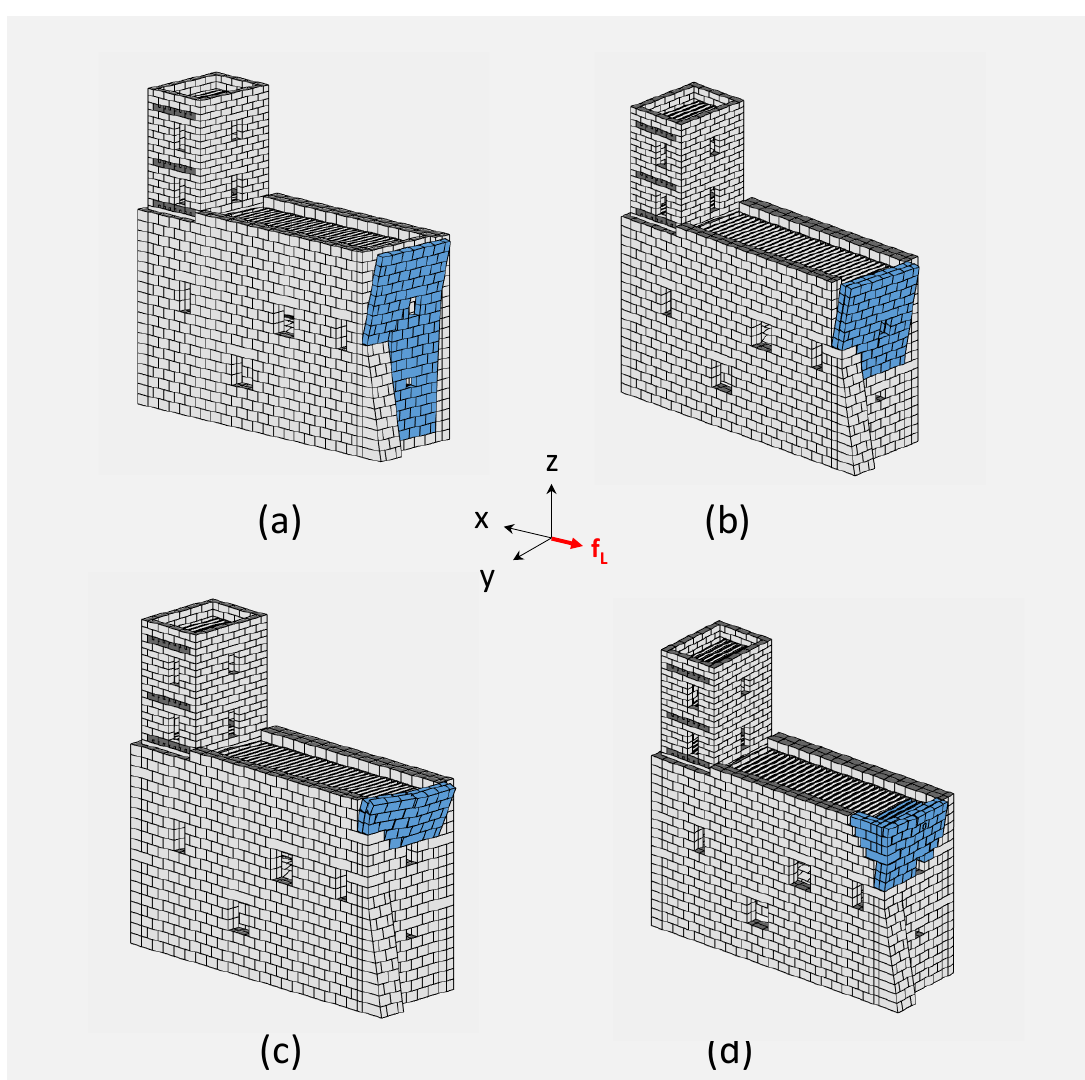
Figure 13. Collapse mechanisms and participating masses (in blue) provided by LiABlock_3D for the load case LC1 (live loads f L along the positive x-axis): ( a ) the castle wing in its present condition; ( b ) retrofitting intervention n.1 (R1); ( c ) retrofitting intervention n.2 (R2); ( d ) retrofitting intervention n.3 (R3). Quoins in red; washer-bearing plates in green.